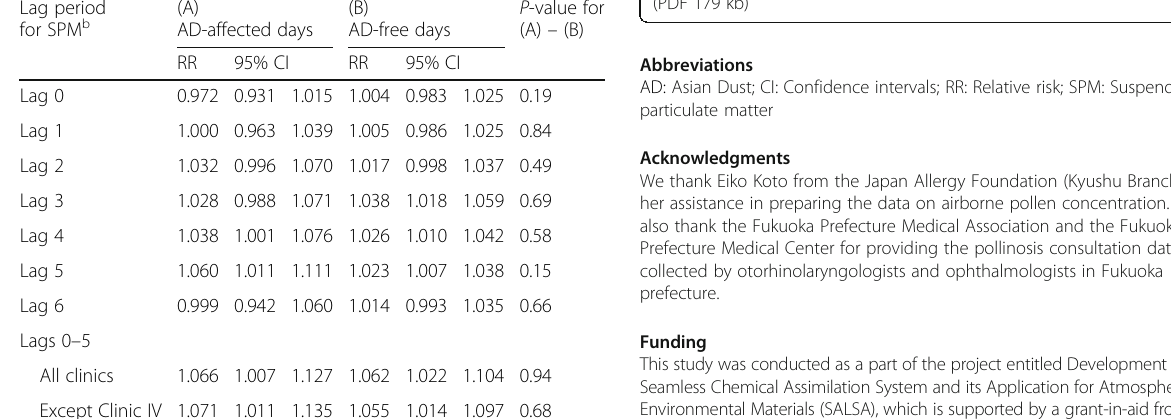
Table 3 Pooled estimates for the relative risk a with 95% confidence intervals of daily medical consultations for pollinosis in association with a 10- μ g/m 3 increase in mean suspended particulate matter, by the presence of AD Lag period for SPM b